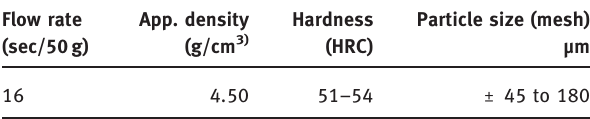
Table 3. Rolled plates of 12mm thickness has been used as the base material. The substrate was preheated to 450 o C to relieve the internal stresses and also to reduce the cooling rate to avoid the formation of cracks after deposition. The average thickness of deposit was about 1 – 2mm on the stain- less steel. Table 4 shows fixing the working range of TS, based on multiple trials the working range has been fixed.